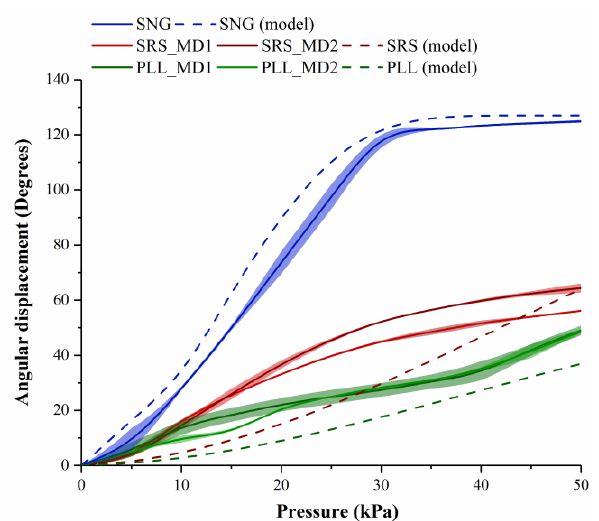
Figure 6. Experimental and predicted angular displacement profiles of assemblies—SNG assembly, SRS assembly, and PLL assembly. SRS and PLL assemblies have two FRA modules, each of which is pressurized selectively. Hence, two sets of angular displacement profiles are presented for the SRS (SRS_MD1 and SRS_MD2) and PLL assembly (PLL_MD1 and PLL_MD2). MD1 refers to the state whereby the first FRA module is pressurized and the second FRA module depressurized. MD2 refers to the state whereby the first FRA module is depressurized and the second FRA module